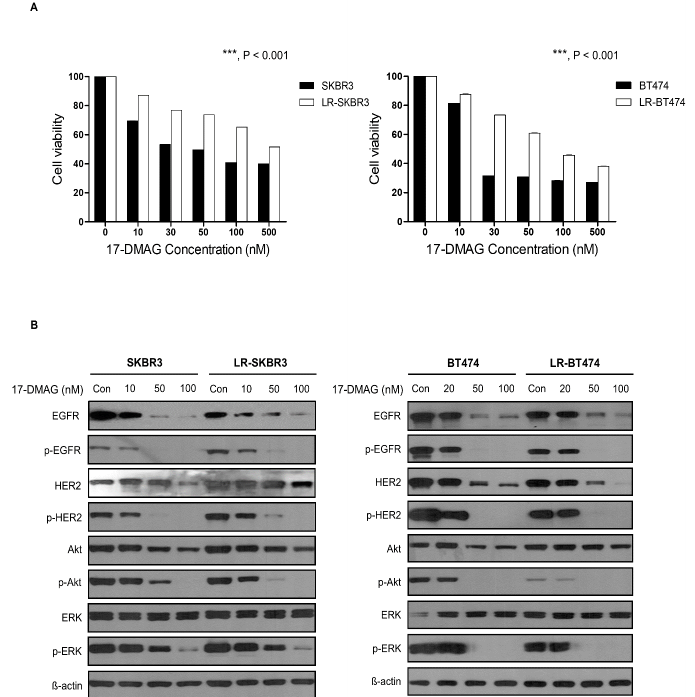
Figure 4. 17DMAG induces inhibition of cell proliferation and affects HER2 downstream signaling in lapatinib-resistant cell lines. ( A ) 17DMAG was administered for 48 and 72 h at different concentrations in parent and lapatinib-resistant cell lines and measured using MTT analysis. Results are expressed as percentage of viable cells from three independent experiments (mean ± SD) (***, p < 0.001). ( B ) Parental and lapatinib-resistant cell lines were treated with 17DMAG at 20, 50, or 100 nM concentrations for 24 h. Western blot was performed using same amounts of protein. Protein activation was analyzed using corresponding p-HER2, p-EGFR, p-Akt, and p-ERK antibodies. Results represent 2 independent